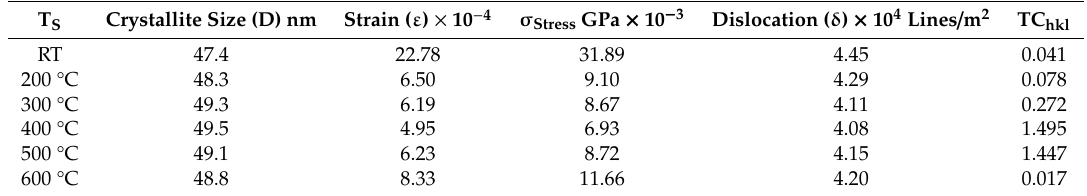
Structural parameters for the Bi 2 O 3 :Ho 3 + (1 mol.%) film deposited at di ff erent substrate